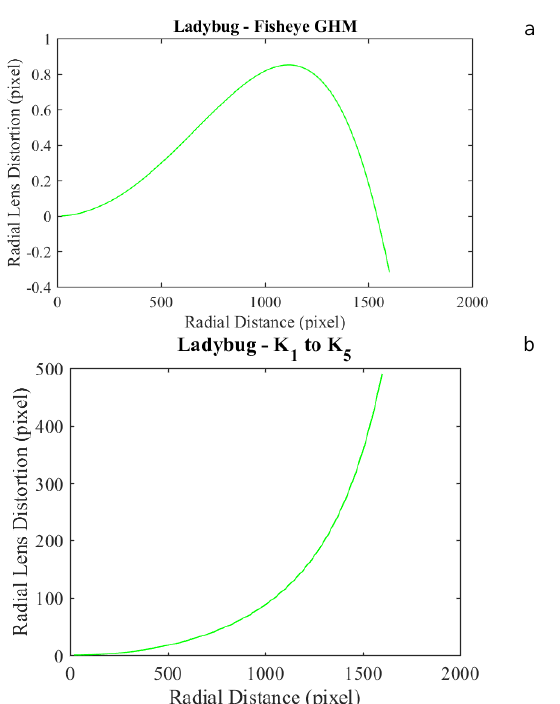
Figure 8. Radial lens distortions of Ladybug5 using a) Fisheye GHM and b) Central Perspective K1-K5.